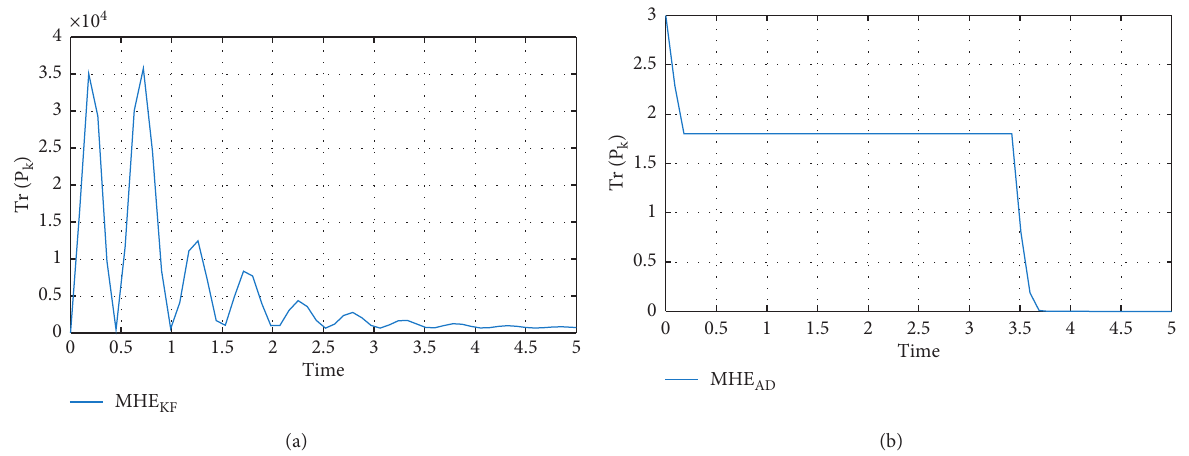
Figure 8: Evolution of trace ( P